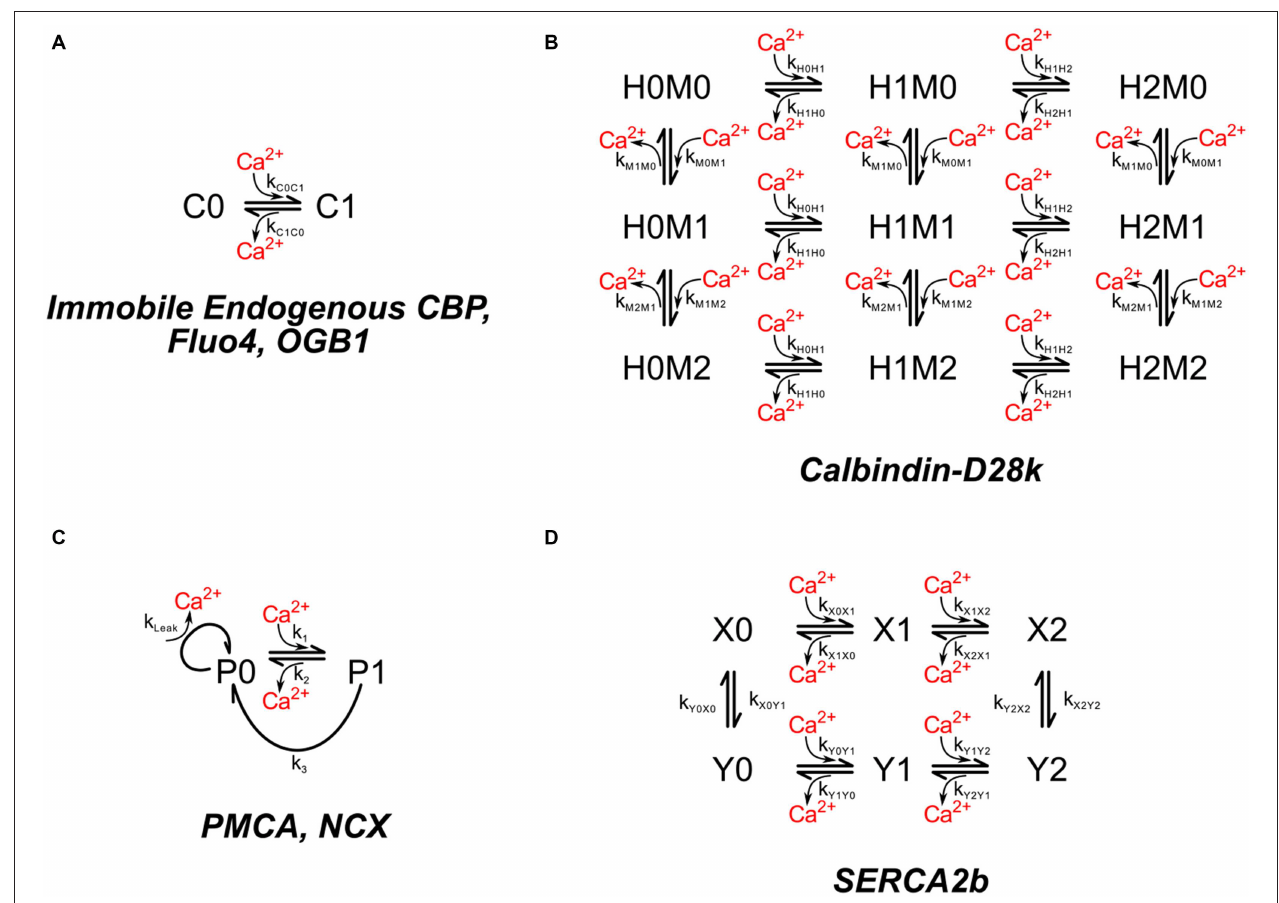
FIGURE 3 | Chemical kinetic schemes of endogenous Ca 2 + buffer, calbindin-D28k, Ca 2 + pumps, and Na + –Ca 2 + exchanger. (A) The interaction of Ca 2 + with immobile endogenous CBPs was modeled as a simple first-order reversible reaction. Molecules of immobile endogenous CBPs were distributed throughout the volume of the dendritic and spine cytoplasm. (B) The mobile high affinity calcium buffer calbindin-D28k was included in the dendritic and spine cytoplasm. (C) Ca 2 + pumps PMCA, and NCX were modeled with identical kinetic schemes but different rate constants. PMCA and NCX pumps were placed on the spines and dendritic shafts. (D) The SERCA pump was placed on ER membrane.